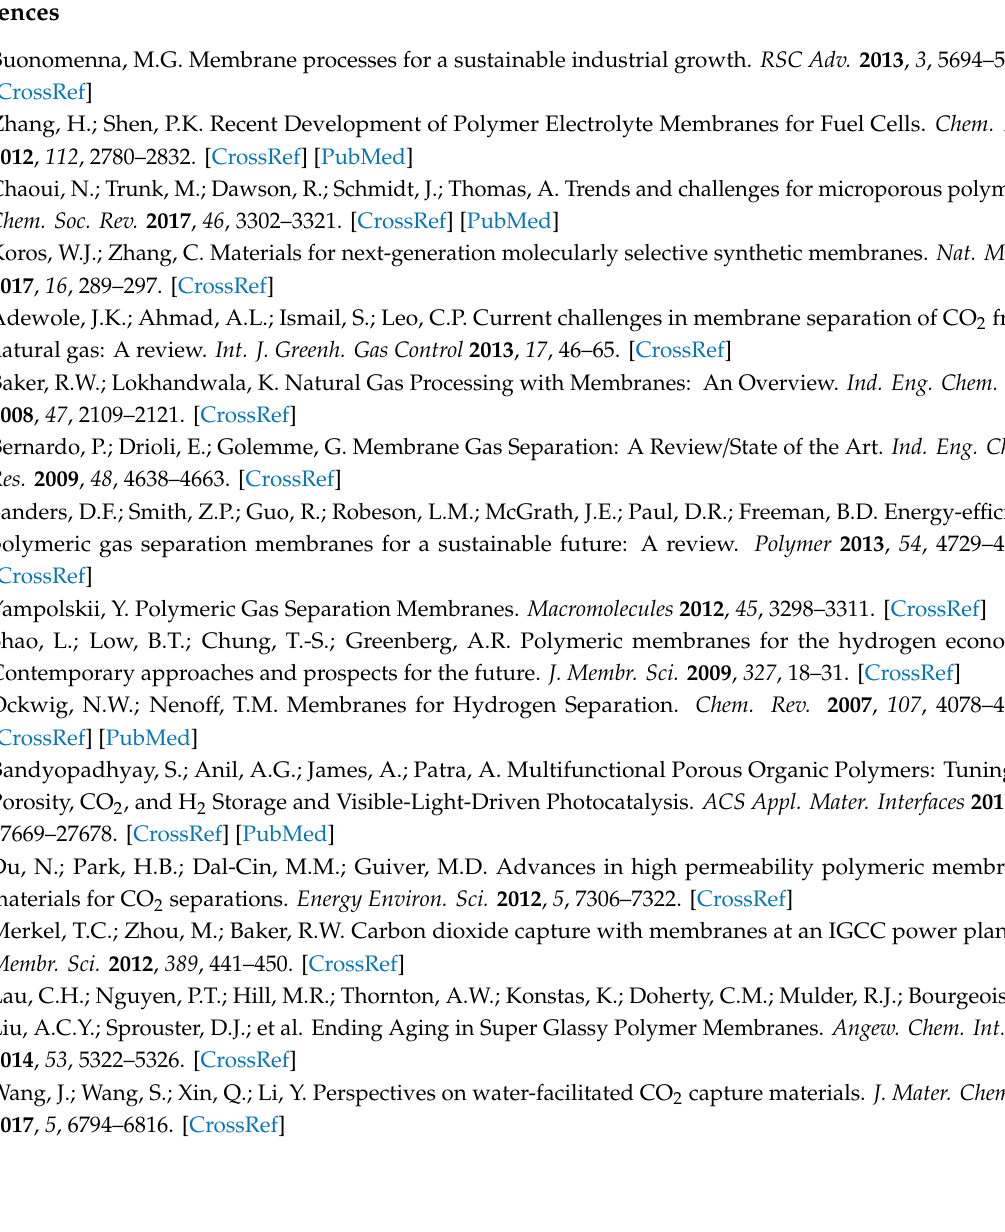
Figure S1: Gel permeation chromatography trace for PIM-Trip(Me 2